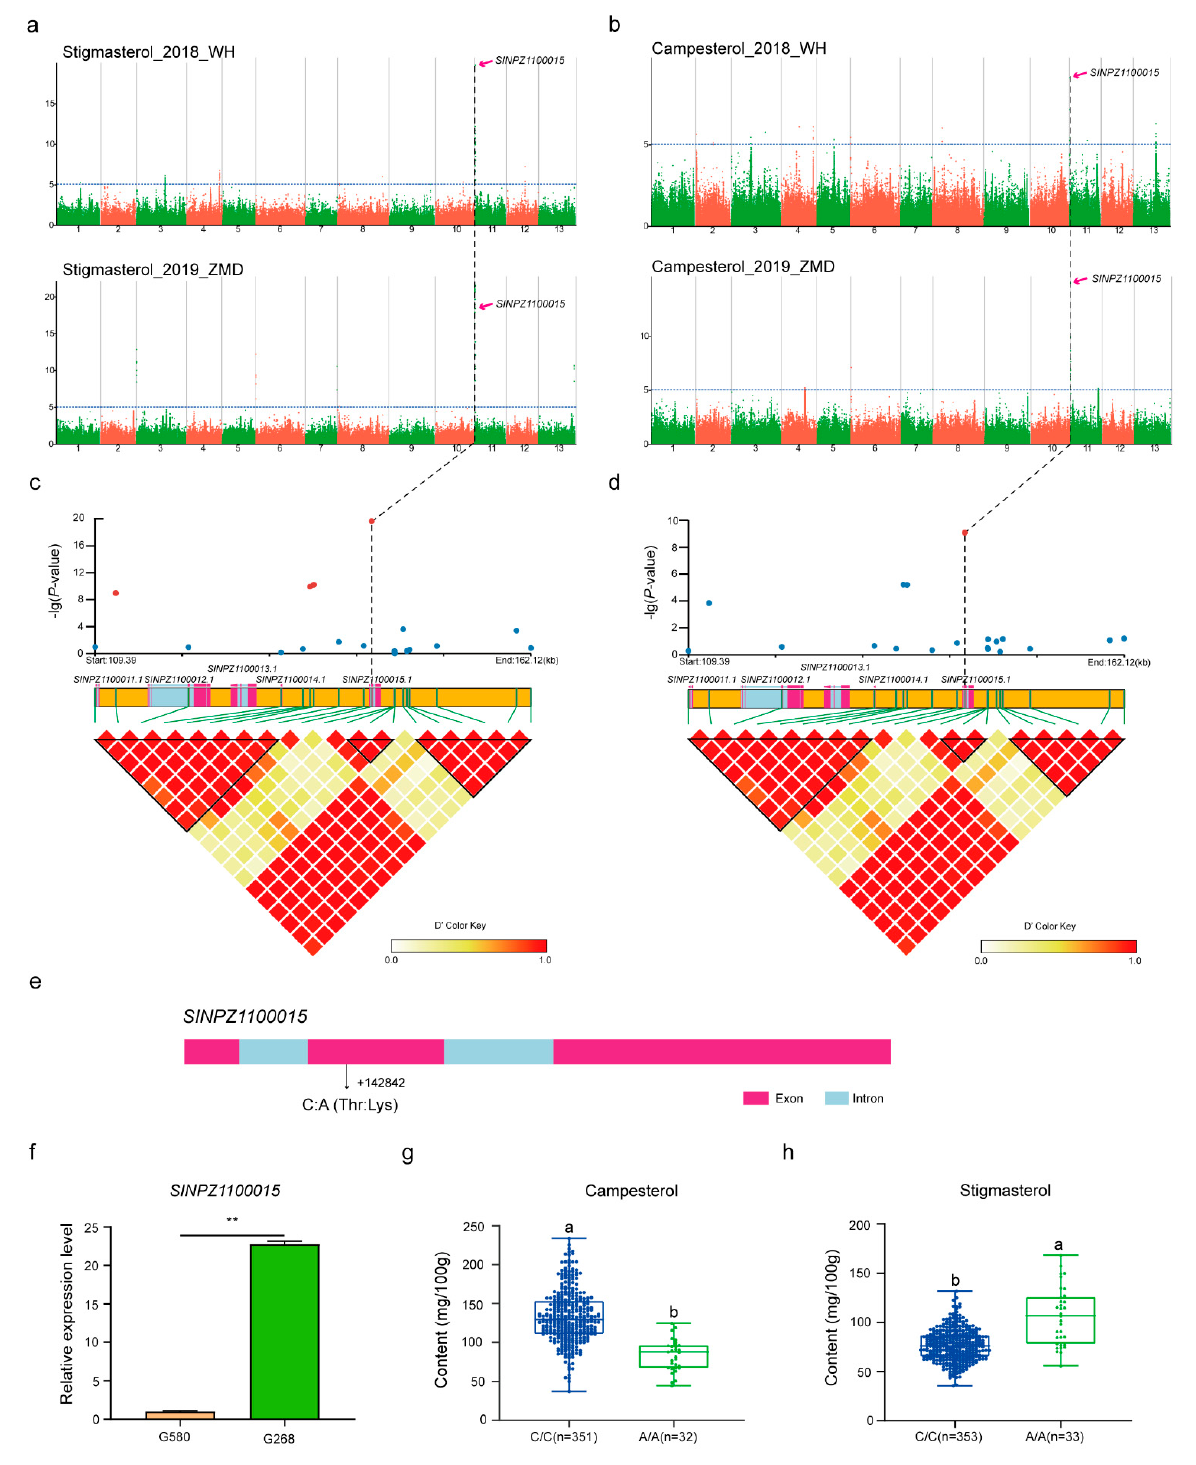
Figure 4. Colocalization, expression, and haplotype analysis of the candidate gene SINPZ1100015 associated with campesterol and stigmasterol content variation in sesame. Manhattan plots of stigmasterol ( a ) and campesterol ( b ) in WH and ZMD. Locus Chr11:142842 LD heatmap for stigmasterol ( c ) and campesterol ( d ). The gene’s structure ( e ). The red and grey rectangles line indicate upstream, exons, and introns, respectively. The bottom left is the synonymous SNP, and the right is the non-synonymous SNP. Expression levels of SINPZ1100015 in G268 and G580 (two contrasting campesterol and stigmasterol content sesame accessions) seed at 20 DPA ( f ). ** indicates significant difference at p < 0.01. Campesterol ( g ) and stigmasterol ( h ) contents in the two haplotypes of SINPZ1100015 . The different letter indicates significant differences at p <